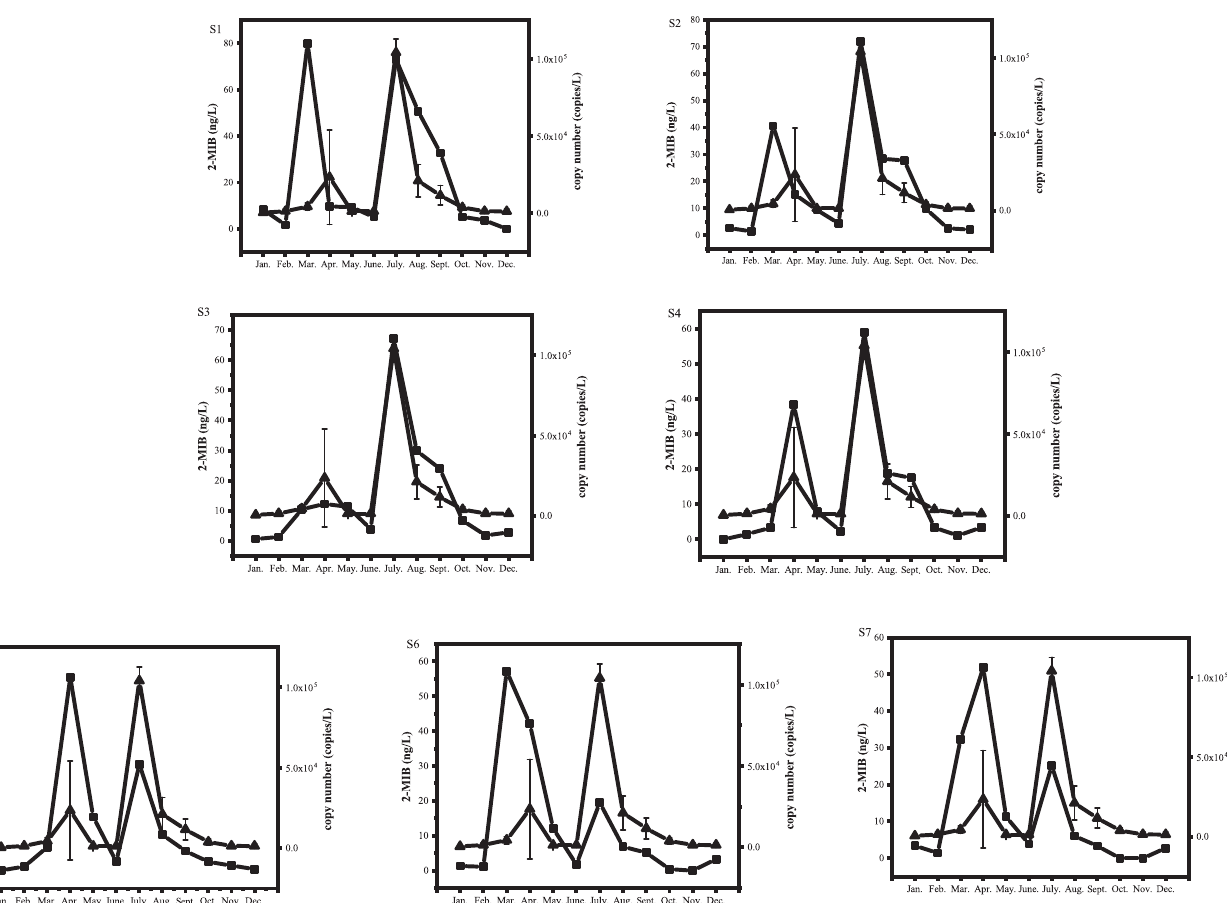
Figure 4. Monthly variation in 2-MIB synthesis gene copies and 2-MIB concentrations at 7 sampling sites in Yanlonghu CW-R. ( (cid:78) ) Copy numbers of 2-MIB synthesis gene revealed through qPCR using MIB-Rf/MIB-Rr primers (triplicates); ( (cid:4) ) 2-MIB concentrations determined using